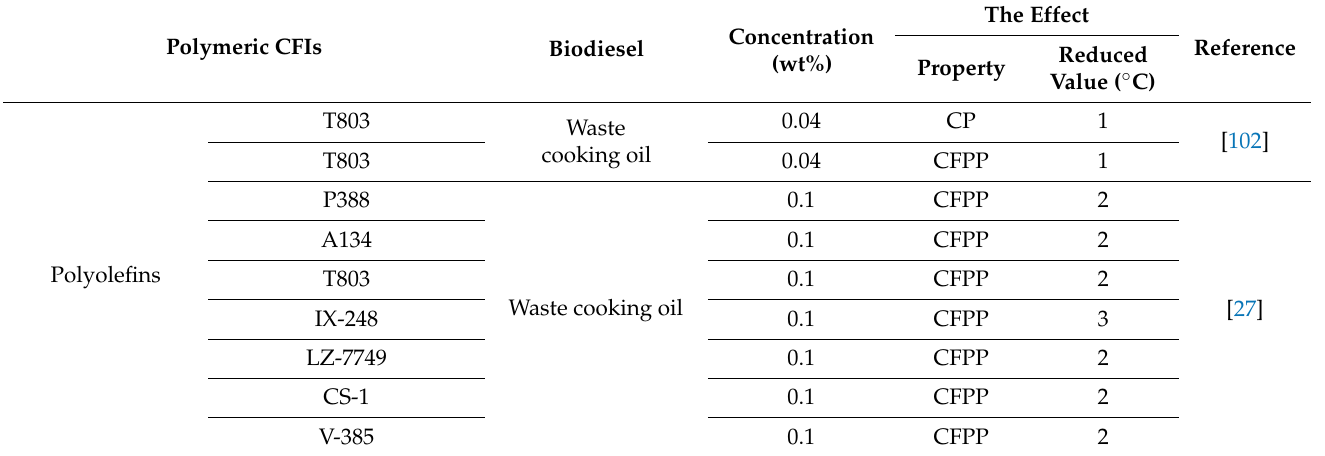
Table 7. Some polymeric CFIs for pure